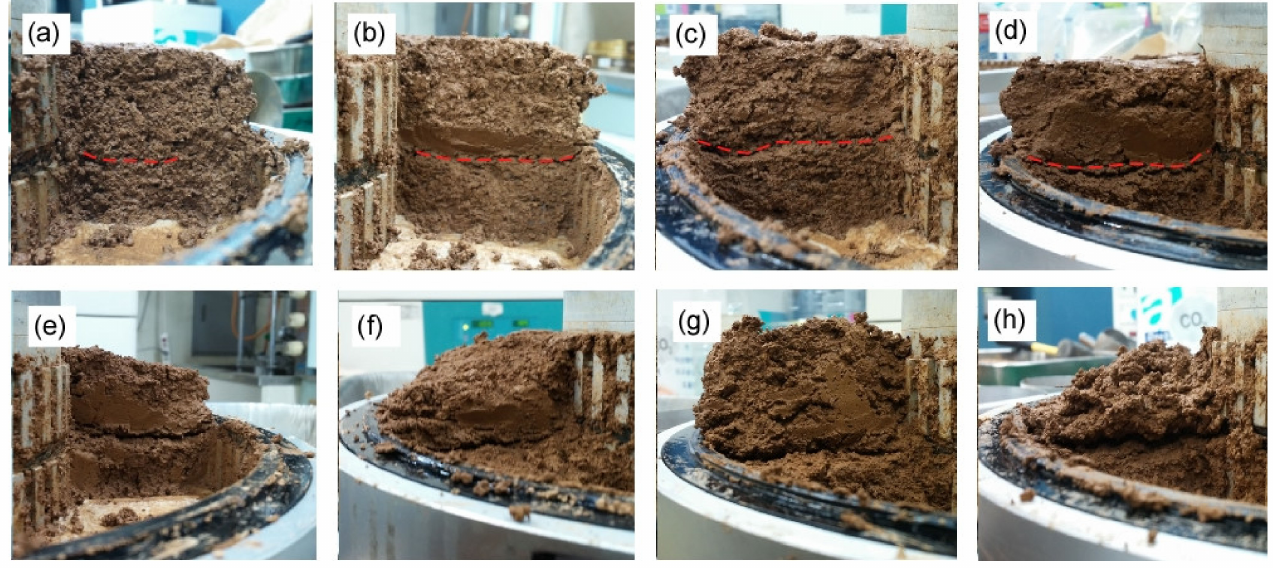
Figure 5. Shear surface observed after testing: ( a , b ) 10 mm, ( c , d ) 30 mm, ( e , f ) 50 mm, and ( g , h ) 100 mm rotation; ( a , c , e , g ) = drained; ( b , d , f , h ) = undrained